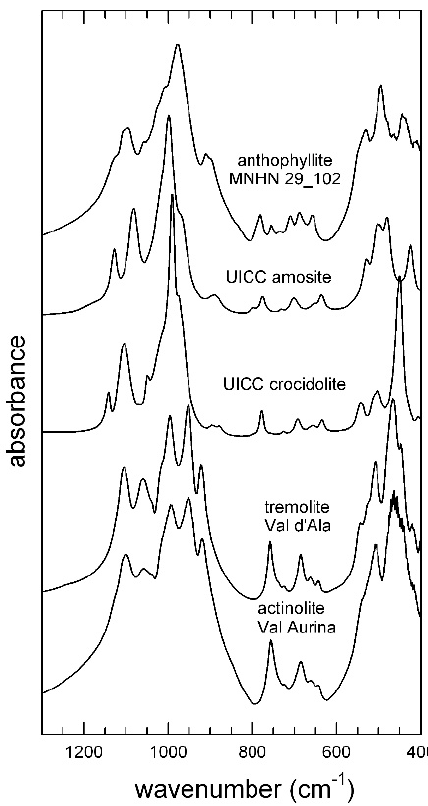
Figure 9. Stacked FTIR spectra in the low-frequency (1300–400 cm − 1 ) region for the amphiboles investigated in this study (see Table 1).